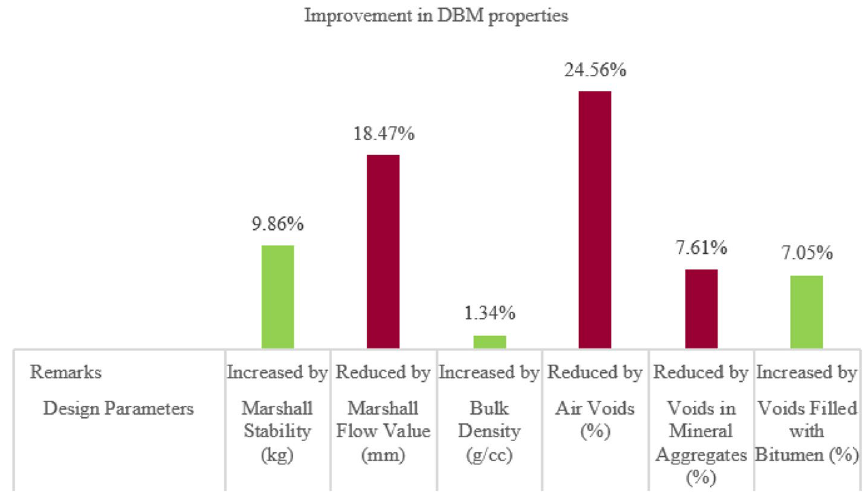
Fig. 31 Enhancement in the properties of modified DBM